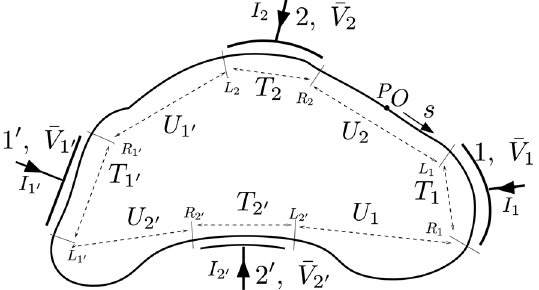
FIG. 7. Arrangement for four-terminal capacitive coupling to a 2D Hall conductor. The coordinate measured along the perimeter is labeled s , the origin of this coordinate is labeled O , ending at the same point at perimeter length P . Terminal segments T are in ¯ V capacitive contact with external electrodes at ac potentials . The left and right L=R end points of the T segments are labeled. T segments are separated by uncontacted insulating segments U . ¼ π = 2 , the response of this device is For the Hall angle θ H independent of the shape of the perimeter of the